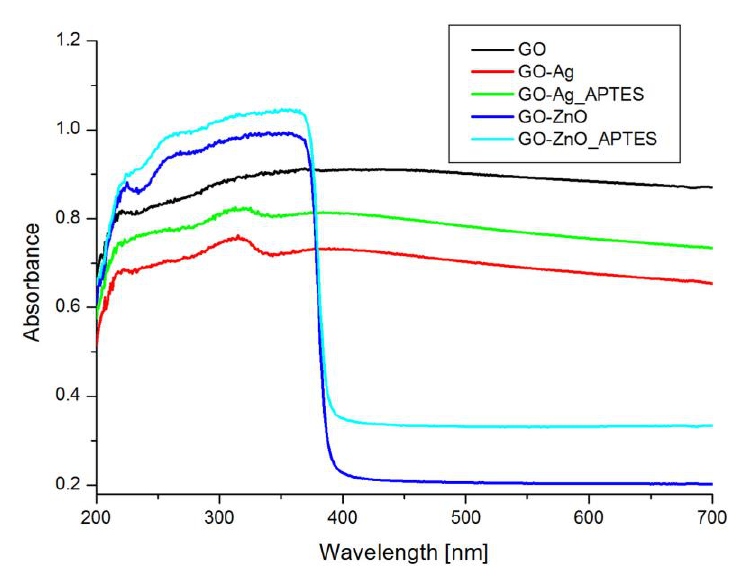
Figure 6. UV-Vis spectra of GO, GO-Ag, GO-Ag-APTES, GO-ZnO si GO-ZnO-APTES powders.